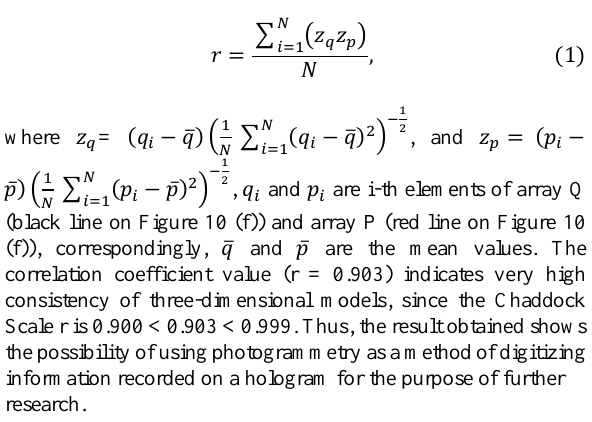
Figure 7. Image of one of the views of the 3D model of the object.